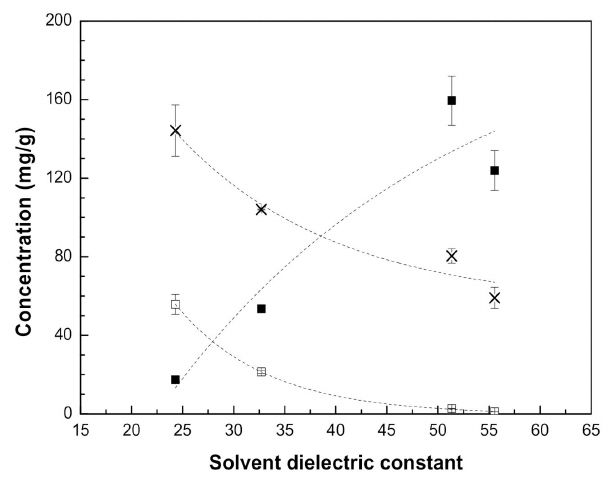
(cid:16) ) total phenolic compounds